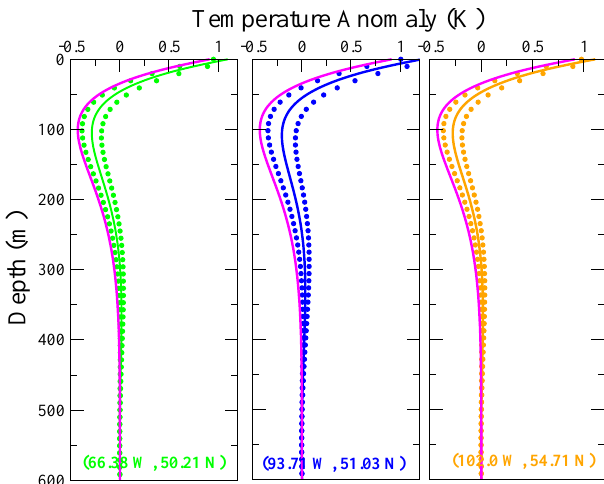
Figure 6. Color lines represent the anomaly profiles from functions Fig. 6. Color lines represent the anomaly profiles from functions in Figure4c. Dotted lines denote the 75% uncertaintyrangeasgeneratedfromtheMUN-GCMsimulations. Pinklinesrepresenttheperturbationfromthe in Fig. 4c. Dotted lines denote the 75% uncertainty range as gen- artificialGSTHinFigure4b. erated from the MUN-GCM simulations. Pink lines represent the perturbation from the artificial GSTH in Fig. 4b.